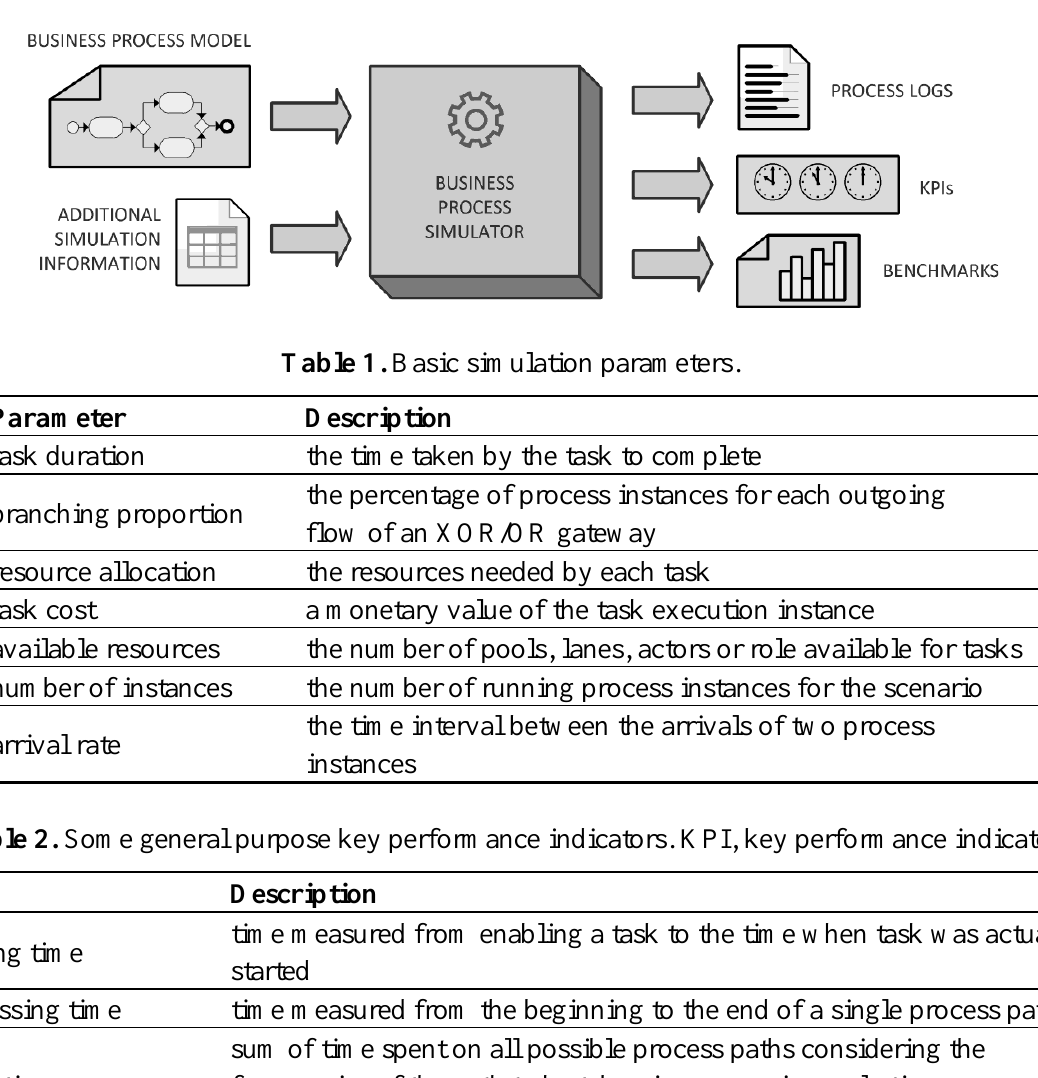
Figure 4. Representation of the input and output data of a business process simulator.